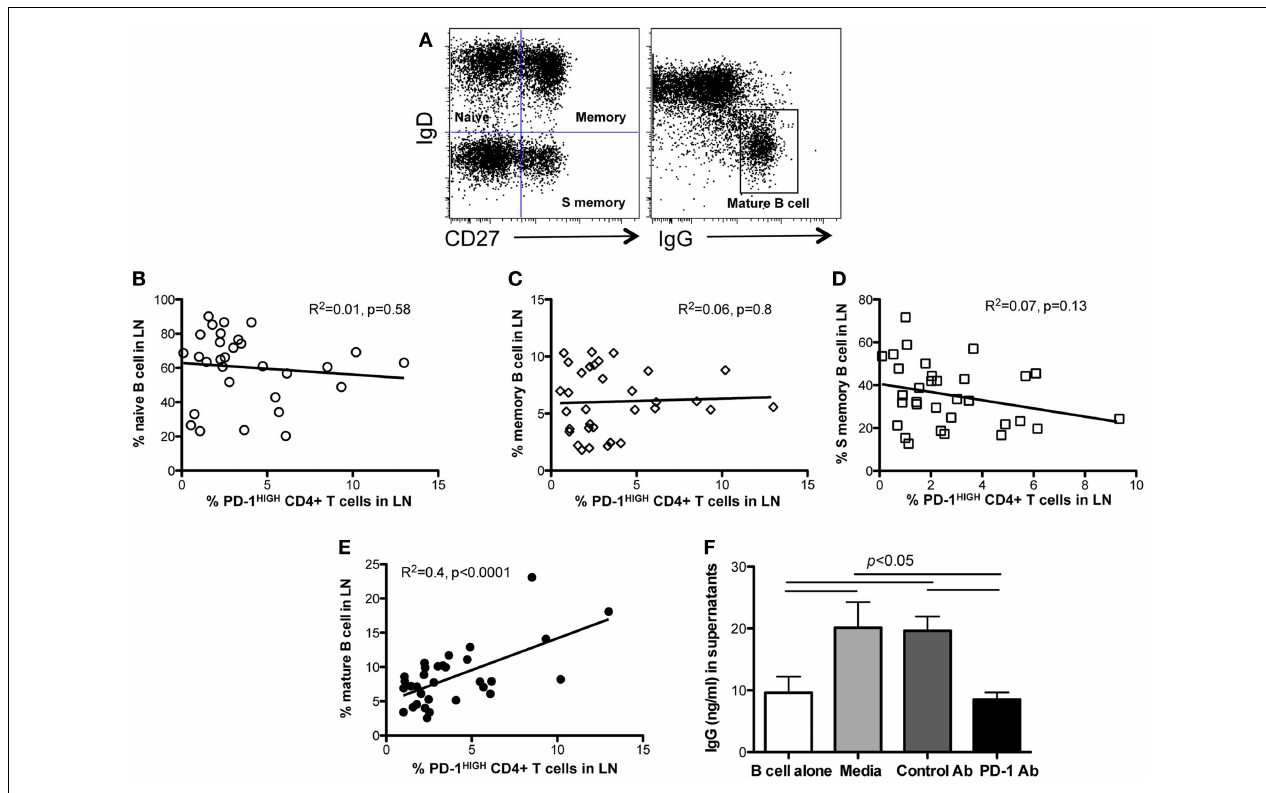
positively correlate with mature B cells in LNs, but not naïve, memory, or switched memory B cells. (F) IgG production in autologous PD-1 HIGH CD4 + T cell and B cell co-cultures after PD-1 blockade. Supernatants were collected 11days after culture and IgG levels detected by ELISA. Note that PD-1 blockade significantly inhibited IgG production in co-culture in vitro .The data in (F) show results from five different normal adult animals, and all experiments were performed in triplicate. *Indicates p <